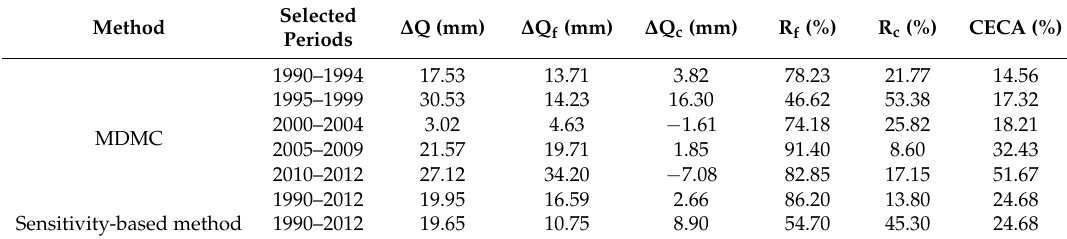
Table 4. Results from Modified Double Mass Curve (MDMC) and sensitivity-based analyses. Where ∆ Q is the change in annual mean streamflow between the observed and predicted, ∆ Q in streamflow attributed to forest change, ∆ Q c is the difference in streamflow attributed to climate variability, R f and R c are the relative contribution of forest change and climate variability to the total change in Q in that period expressed as a percentage. CECA is the average cumulative equivalent clear-cut area for the selected periods.